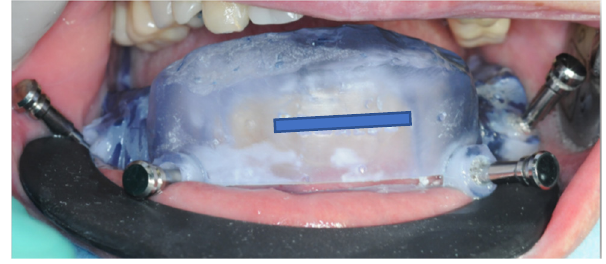
Figure 9. Insertion of the anchor pins in the positional guide.